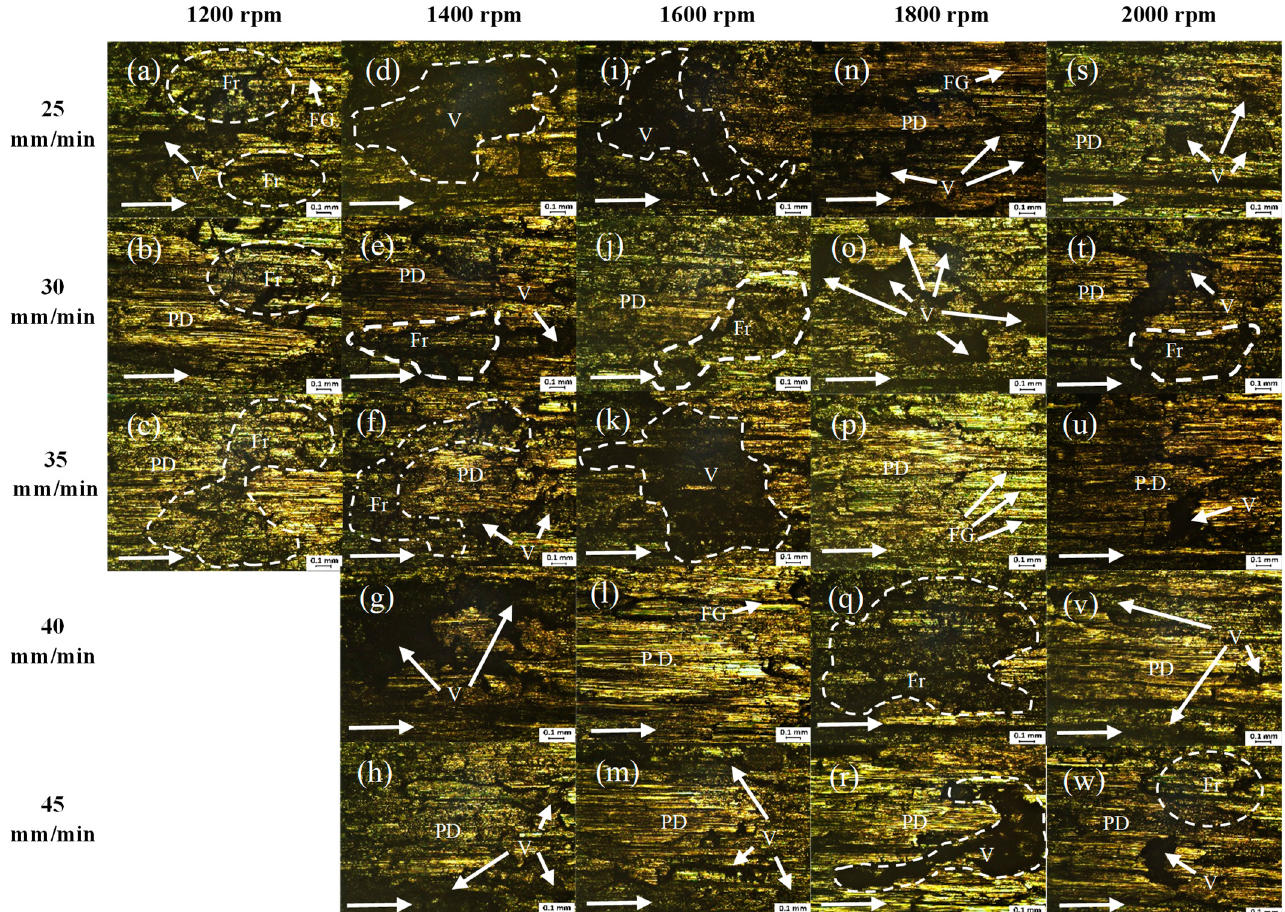
starved lubrication conditions, normal contact pressure of 0.24 MPa, sliding speed of 2.88 m/s, and sliding distance of 1500 m. (PD: Plastic Deformation, Fr: Fracture, V: Void, and FG: Fine Groove; arrow at bottom left corner showing sliding direction).